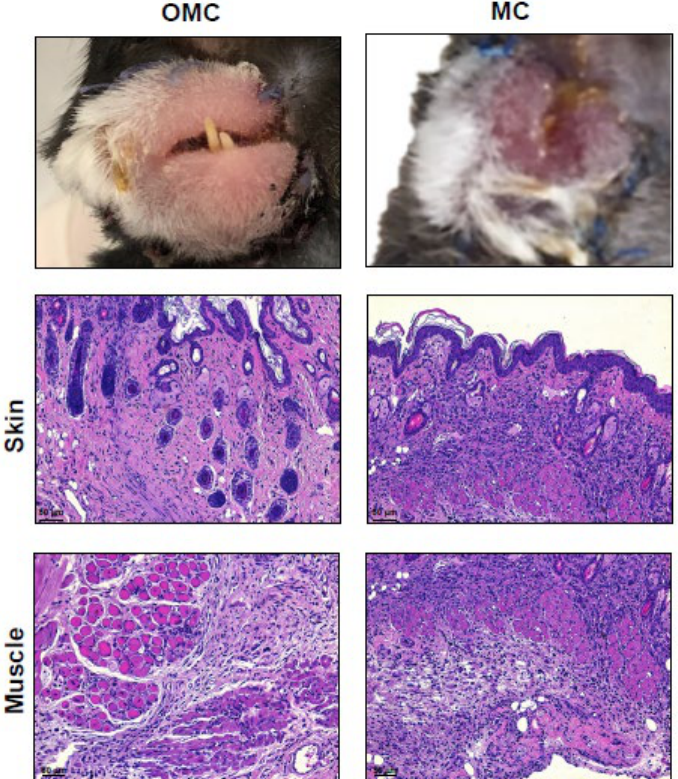
Figure 3. Degree of lymphocyte infiltration into facial allograft. Macroscopic and histological changes (indicated by hematoxylin and eosin staining) in facial allografts of osteomyocutaneous (OMC) and myocutaneous (MC) groups receiving 0.6 mg/kg of FK506 on postoperative day (POD) 14. Dense violet staining demonstrates infiltrating lymphocytes in the skin and muscle layers of the facial allograft. Scale bars are 50 μm.